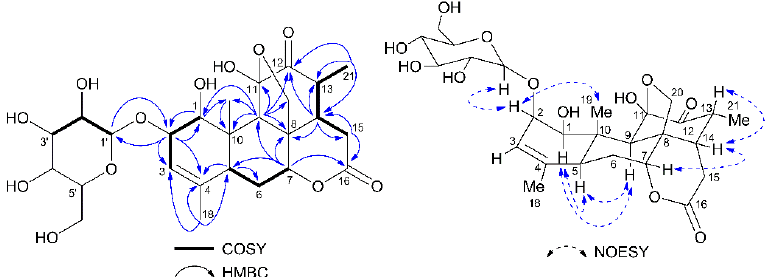
Figure 2. Selected HMBC (arrows), 1 H- 1 H COSY (bold lines) and key NOESY (dashed arrows) correlations of compound 1 .